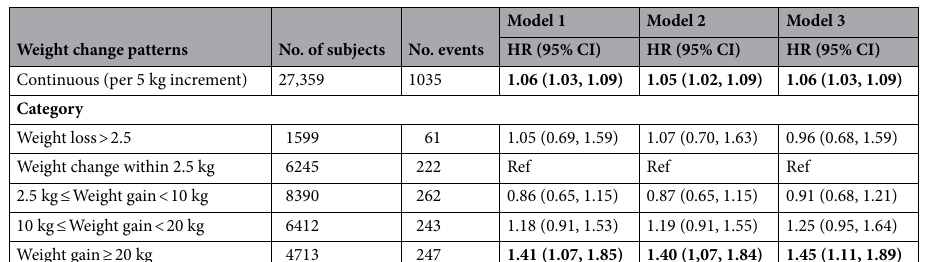
Stratified analyses and sensitivity analysis. The results of the stratified analyses according to base- line age, gender and smoking strata are shown in Table 6. In each subgroup, non-obese to obese group was associated with a higher risk of asthma. Stable obesity significantly increased the risk of asthma in the female subgroup, baseline age < 50 years old subgroup and non-smoking subgroup. The results of interaction analyses